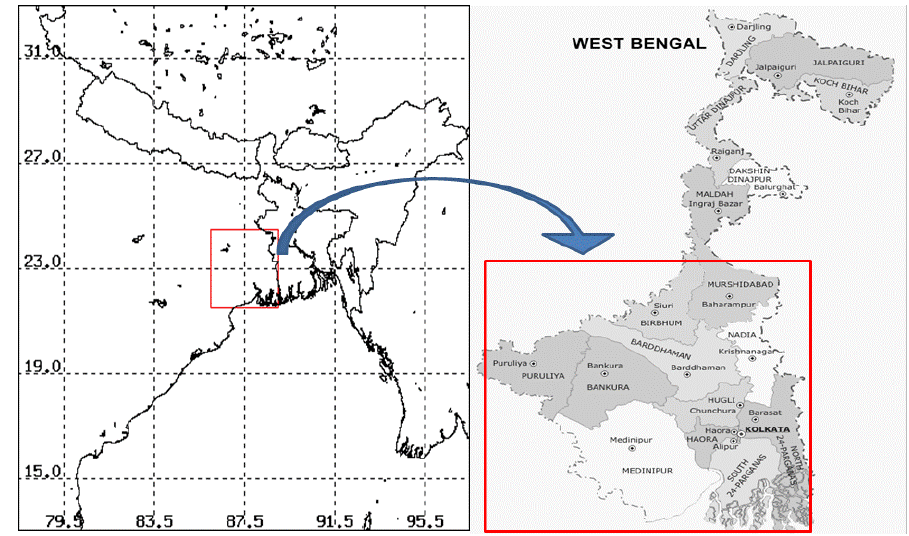
Figure 1. Area of interest (red rectangle), Gangetic West Bengal of India (latitude: 21.5° N to 24.5° N; longitude: 86.0° E to 89.0° E). Source: LIS (Lightning Imaging Sensor) and Maps of India.